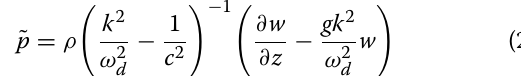
for the wave field at z < H . Note that h − 1 d h/ d z in the right side of Eq. (24) equals the value of the logarithmic derivative, T − 1 d T/ d z , of the absolute temperature, T , just below the interface z H . Equation (23) and the relation = (Godin 2015)